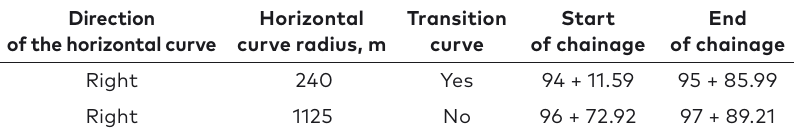
Table 3. The curvature of Section 1 according to the chainage Direction of the horizontal